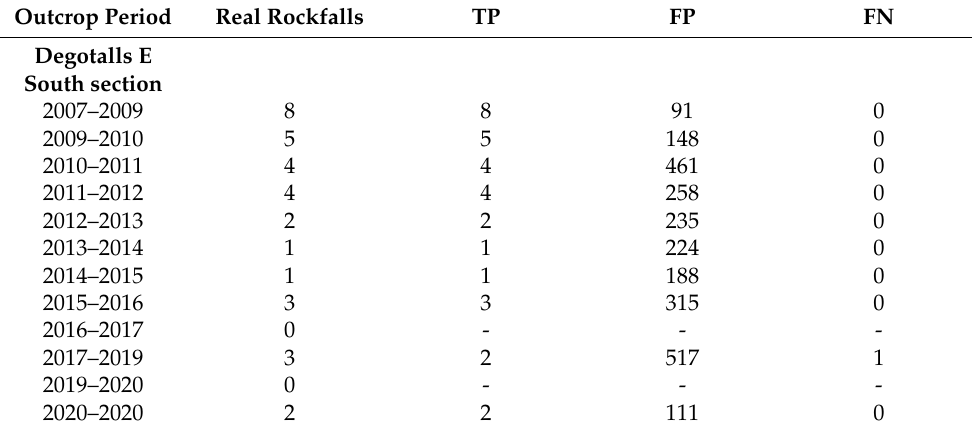
Table 10. Quadratic discriminant analysis model and polynom-fit-SMOTE resampling results. This combination shows the best model for the 2007–2009 comparison, but not for the following compari- son in true positive (TP), false positive (FP) and false negative (FN) results.